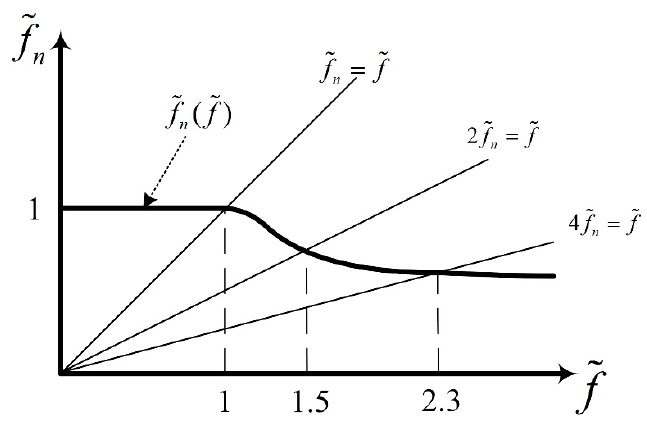
Figure 13. Relationship between the reduced natural frequency (cid:101) f n and the reduced control frequency (cid:101) f .